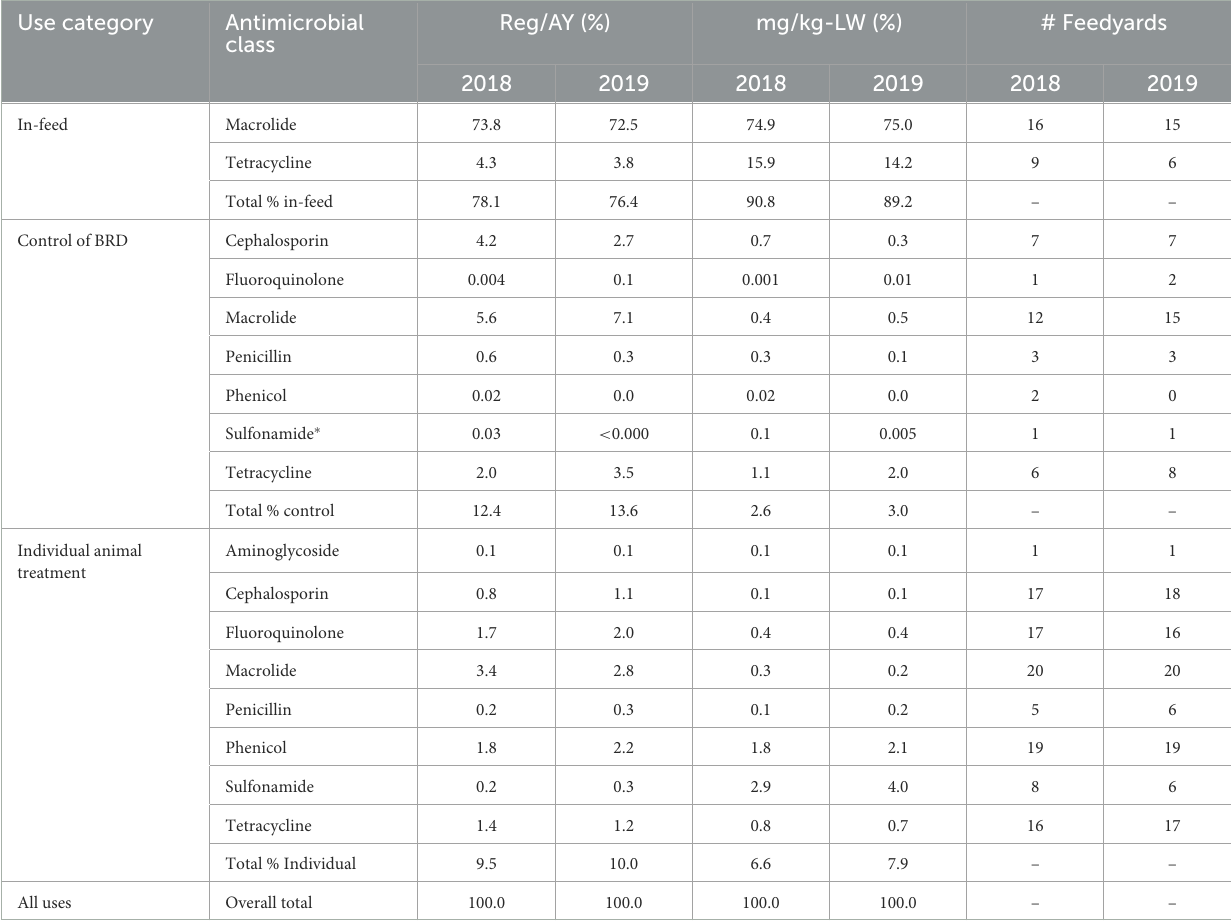
TABLE 6 Medically important Reg/AY and mg/kg-LW by antimicrobial class at the study level with feedyard count, expressed as percentages of the total value for that